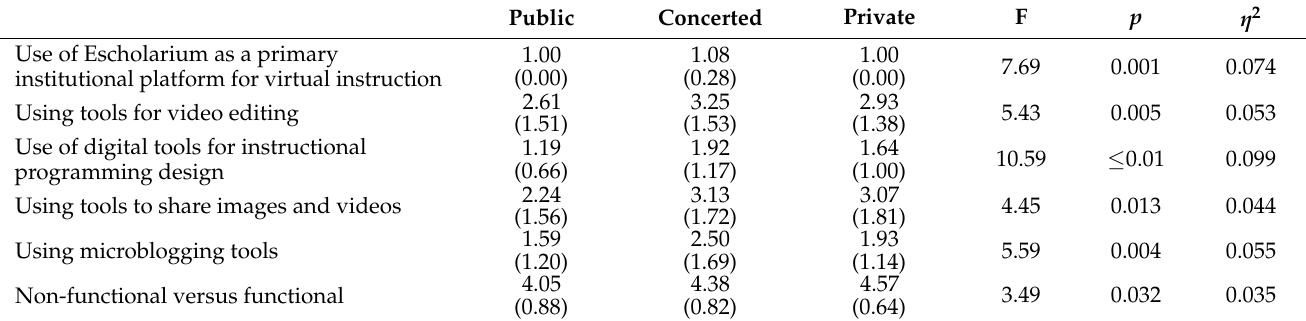
Table 4. Testing of inter-subject effects based on the type of